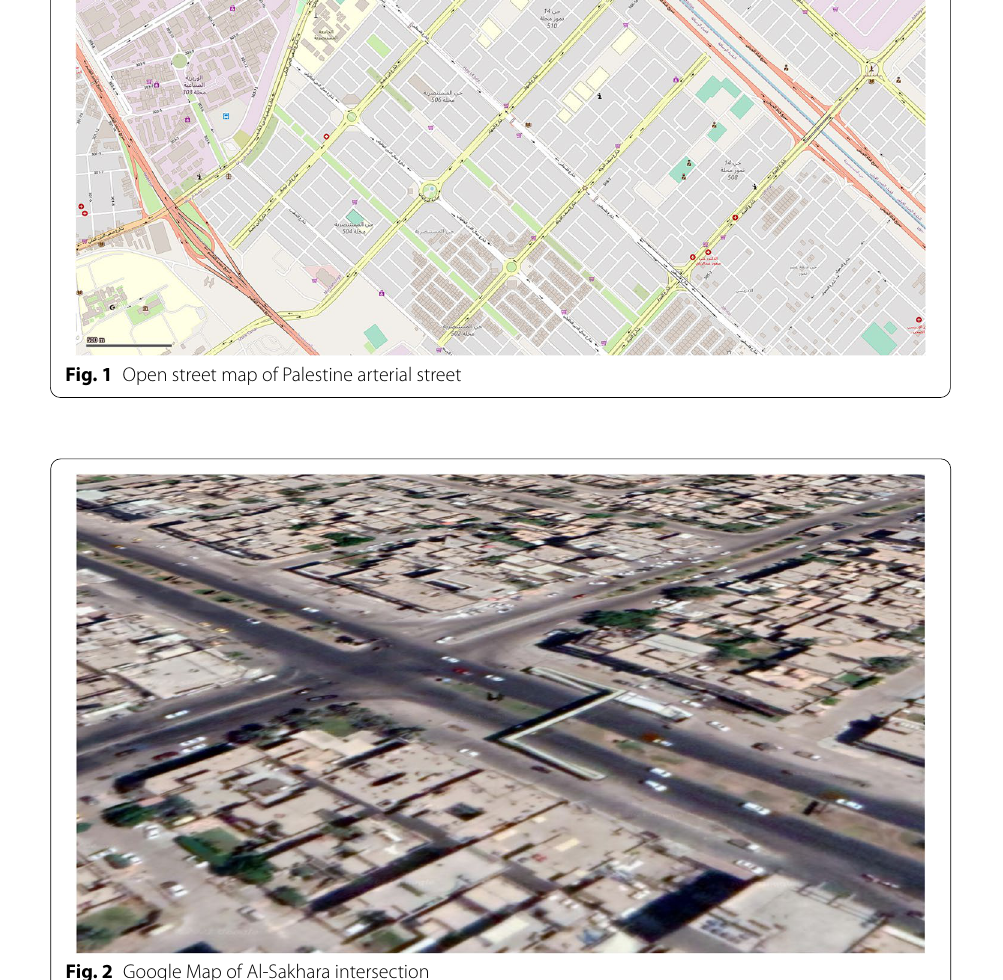
Fig. 2 Google Map of Al-Sakhara